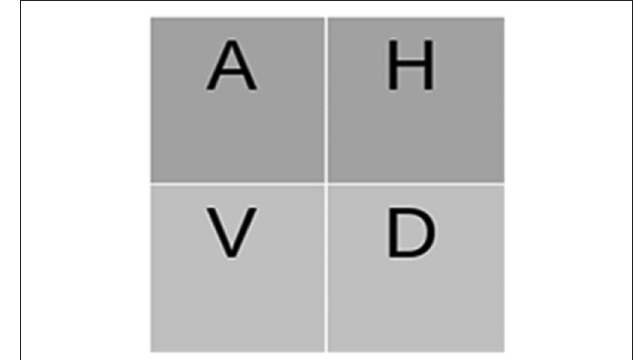
FIGURE 4 | DWT Decomposition: The coefficient image (A) is again decomposed in multilevel DWT